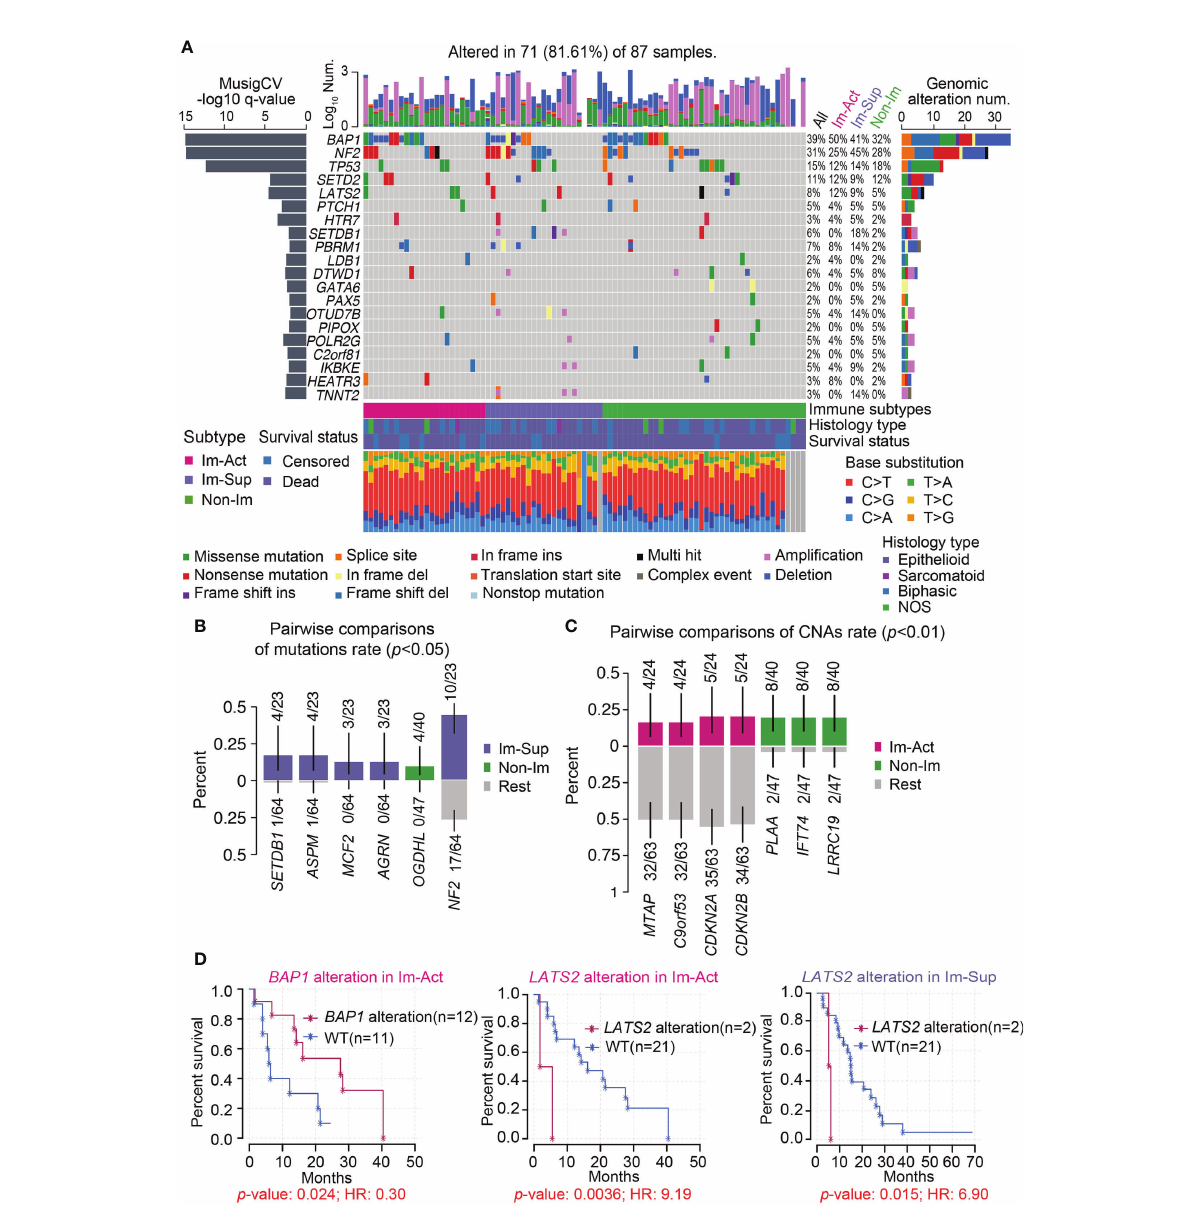
FIGURE 4 Genomic landscape of the three MPM immune subtypes. (A) Oncoplot representation of the distribution of genomic alterations (mutations and copy number variations) in driven genes identi fi ed by Mutsig across the three MPM immune subtypes, with the signi fi cance of mutations (Log10 transformation of MutSig q-value) shown at the left panel. Genomic alterations frequency of all MPM samples strati fi ed by immunological subtypes were listed on the right side of the Oncoplot. The top column illustrates the overall counts of genomic alterations per sample with Log10 transformation, and the column at the bottom presents the mutation spectrum of base substitutions. NOS, Not otherwise speci fi ed. Del, Deletion. (B, C) Identi fi cation of signi fi cantly enriched mutations (B) , p < 0.05) or CNAs (copy number alterations) (C) , p < 0.01) of genes for each subtype by pairwise comparisons. The upper and bottom columns indicate the alteration rate in enriched subtype and the other subtypes respectively. (D) Kaplan-Meier curves of the overall survival in the corresponding subtype of MPM patients strati fi ed by BAP1 or LATS2 genomic alteration status. WT,